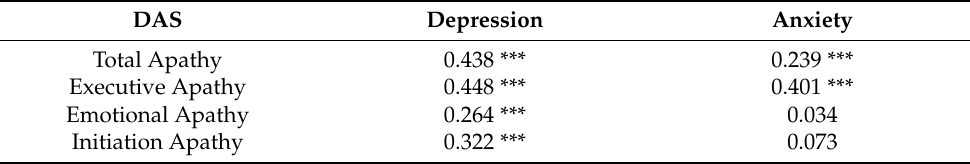
Table 6. Overall correlations between DAS apathy and DASS depression and anxiety. DAS